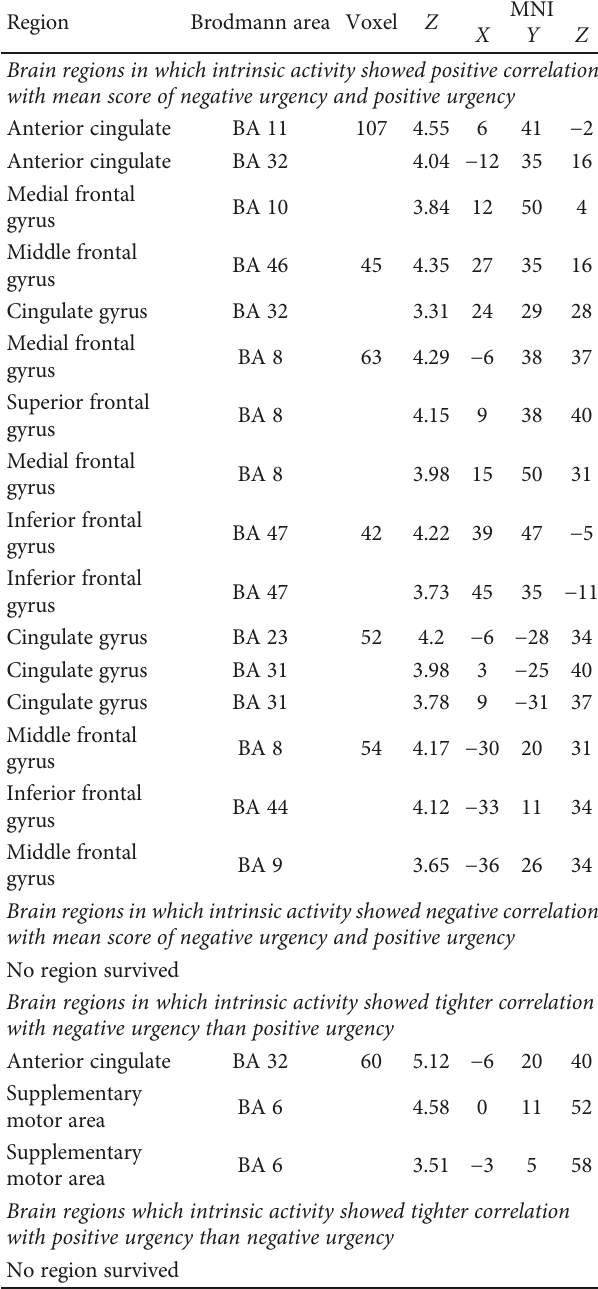
Table 1: The foci of brain areas showed intrinsic activity associating with trait urgency ( P FWE = 0 05 , family-wise error correction). Region